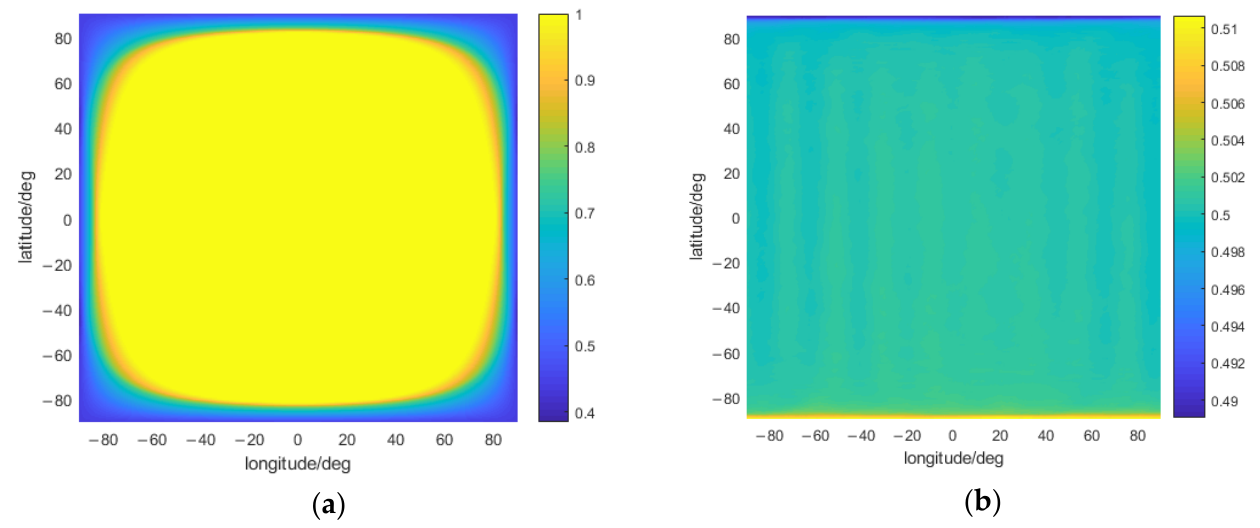
Figure 1. The mean time coverage of ( a ) Earth disc observation and ( b ) sunlight. Figure 1a also indicates that the areas of lower latitudes have higher Earth disc observation performance than those of higher latitudes. Specifically, the time percentage of Earth disc observation drops sharply from almost 100% to lower than 50% when the latitude is greater than 80 ◦ because of the tide lock and curvature occlusion of the Moon surface. As shown in Figure 1b, although the Moon rotation period is about 27.32 Earth days, much longer than the Earth rotation period, the calculation period is approximately equal to the long nutation period (i.e., 18.6 years). The near side almost has the same TCS, except for the two poles with slightly smaller values than other areas. Polar day and night will appear at the poles due to the 1.54 ◦ angle between the Moon orbit and the ecliptic orbit. For other scientific studies, the observed TA centered on Earth’s centroid is the plasma-sphere/magnetosphere shown as the red dotted line in Figure 2. The Earth’s plasma layer locates above the Earth’s ionosphere and extends to an annular plasma area within about 3–6 times that of the Earth’s radius, and its spatial distribution overlaps with Earth’s radiation belt and the ring current area, all of which are important contents of Earth’s inner magnetosphere research [24]. As shown in Figure 2, the MBSEO around the near side can even cover the whole plasma-sphere/magnetosphere compared to the space method, and can be a supplementary gazing observation for deep space.